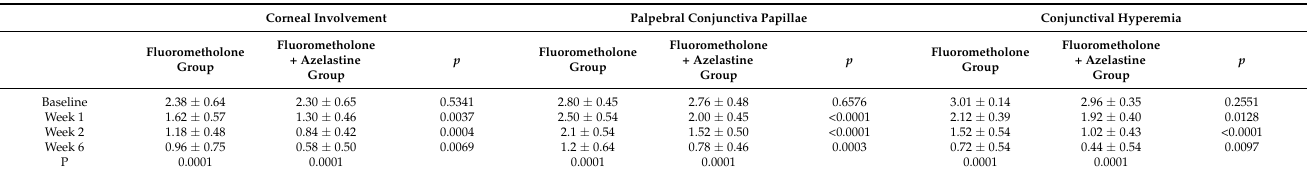
P indicates the within-group differences. p indicates the between-group differences.